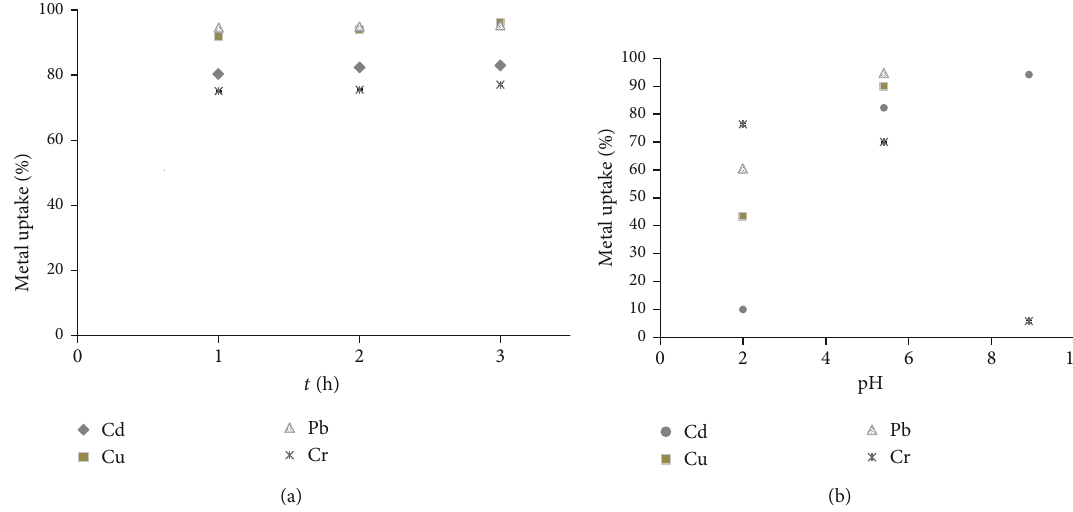
− 1 , pH = 5 : 4 , and i = 5 mgL